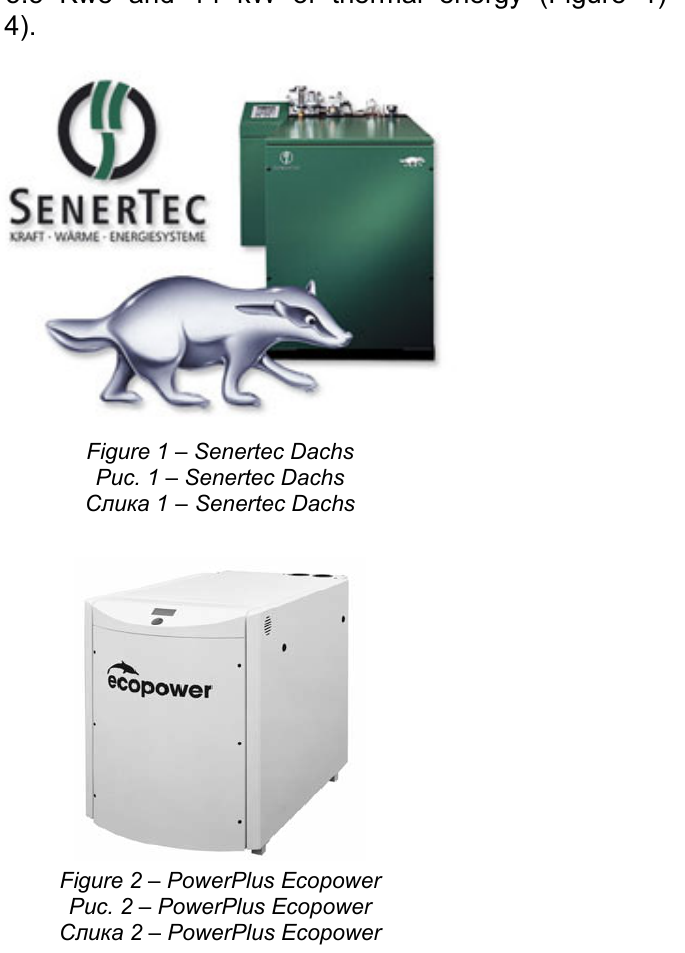
Figure 2 – PowerPlus Ecopower Рис . 2 – PowerPlus Ecopower Слика 2 – PowerPlus